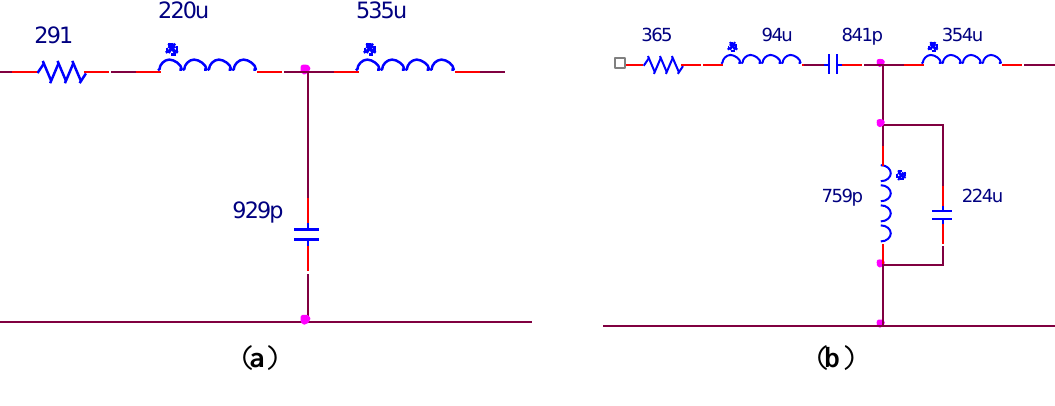
Figure 11. Results of two algorithms considering weight: ( a ) RFT; ( b ) algorithm introduced in Section 2.